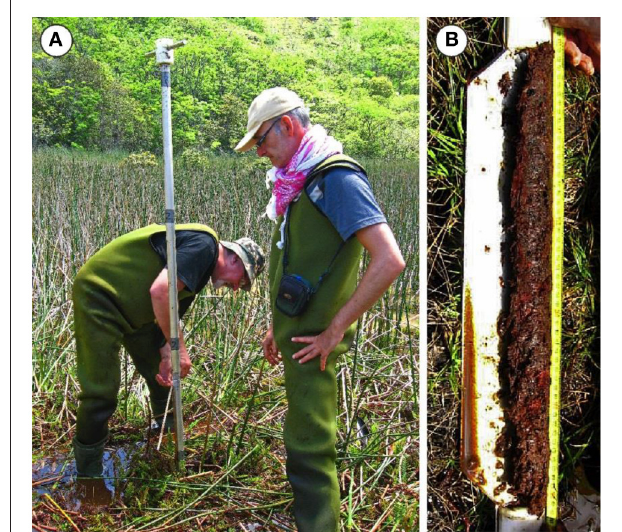
FIGURE 8 | Coring the Rano Kao floating mat. (A) Two members of the 2008 expedition (V. Rull and S. Pla) coring the floating mat of Rano Kao with a Russian corer at site KAO08-03. (B) Drive 2 (131-181cm) of core KAO08-03 showing the fibrous brown peat.